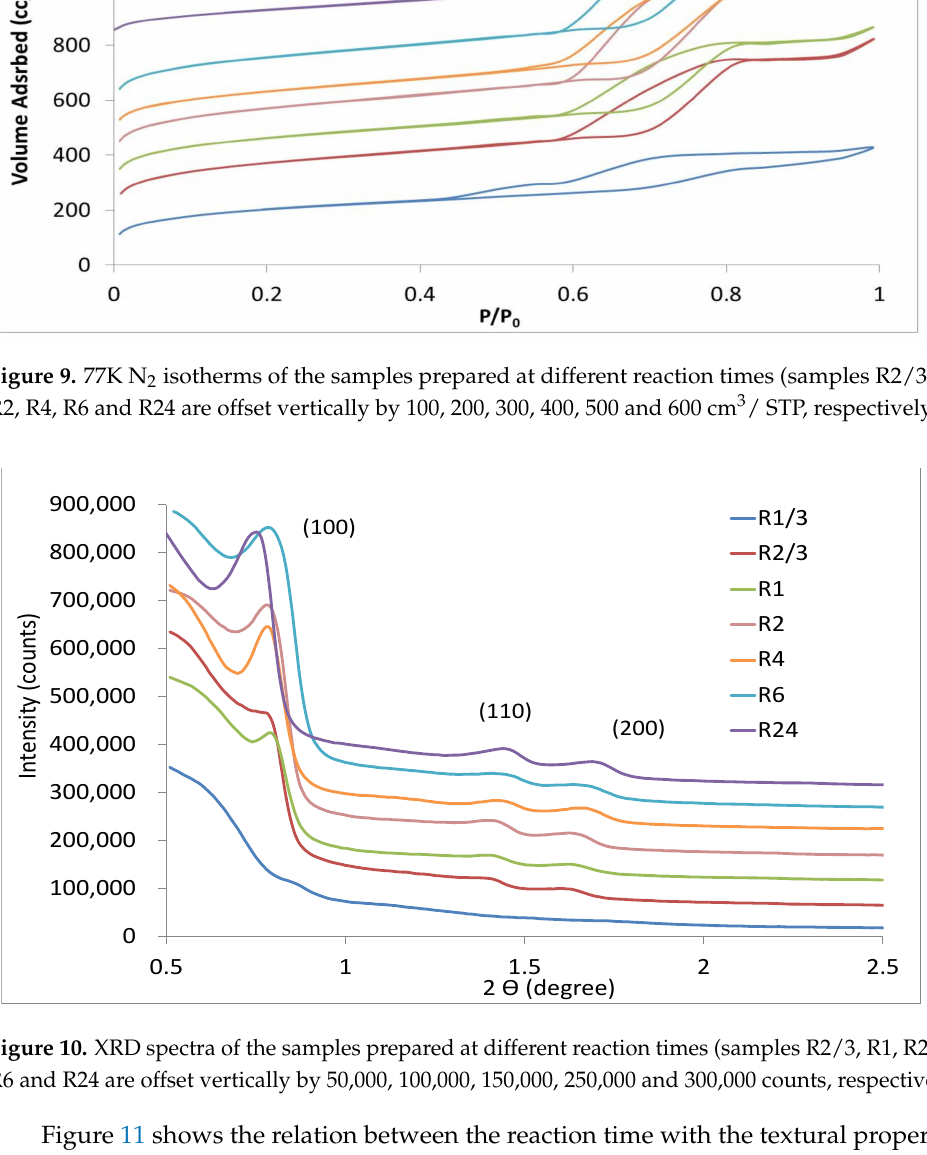
Figure 10. XRD spectra of the samples prepared at different reaction times (samples R2/3, R1, R2, R4, R6 and R24 are offset vertically by 50,000, 100,000, 150,000, 250,000 and 300,000 counts, respectively).